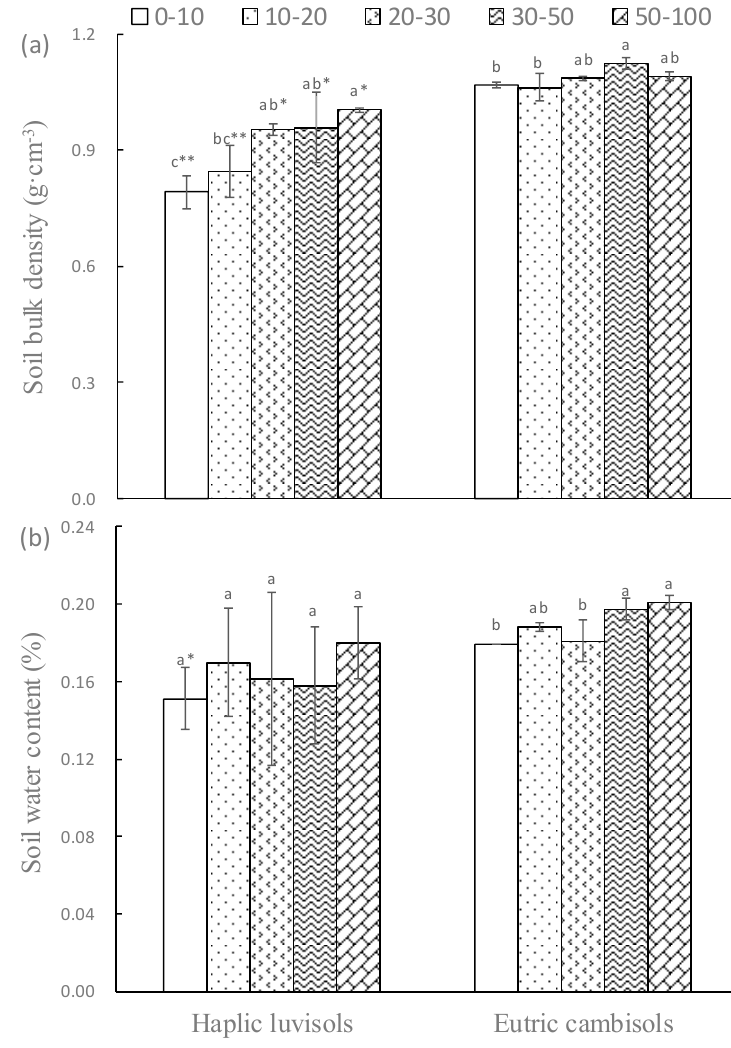
Figure 1. The soil bulk density bulk and water content in the Haplic luvisols ( a ) and Eutric cambisols ( b ). Different lowercase letters indicated a significant difference among soil depth in the same forest soil; * and ** indicates significant ( p < 0.05) and extremely significant ( p < 0.01) differences between the two forest soils in the same soil depth, respectively. The same below.